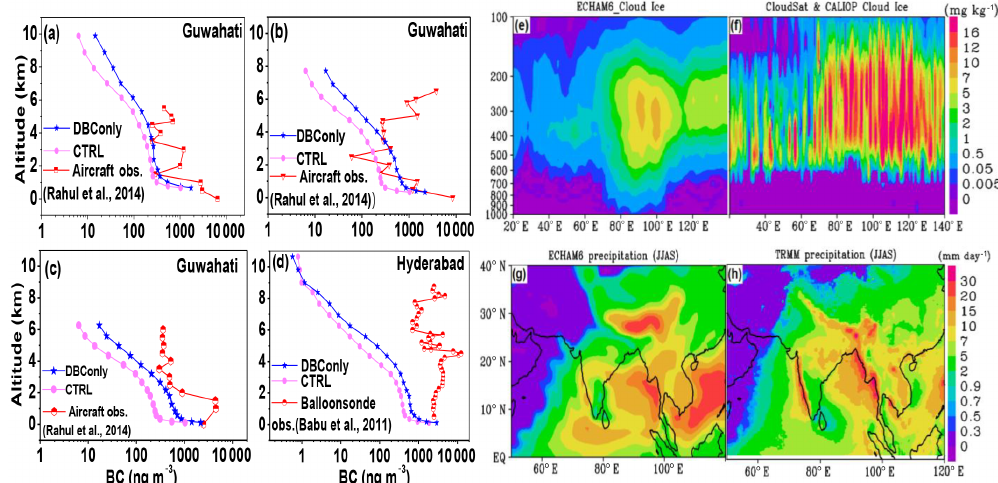
Figure 2. Vertical distribution of BC aerosols (ngm − 3 ). (a) Aircraft measurements on 30 August 2009 at Guwahati (26 ◦ 11 (cid:48) N, 91 ◦ 44 (cid:48) E) (Rahul et al., 2014), CTRL and DBConly simulations for that month extracted at a grid centered at Guwahati. (b) Same as (a) but observations for 4 September 2009 and simulations for the month of September. (c) Same as (a) but for observations on 6 September 2009 and simulations for the month of September. (d) Balloon-borne measurement on 17 March 2010 at Hyderabad (17 ◦ 48 (cid:48) N, 78 ◦ 40 (cid:48) E) (Babu et al., 2011) and CTRL and DBConly simulations for the month of March at a grid centered at Hyderabad. (e) Seasonal mean distribution of cloud ice mass mixing ratio (mgkg − 1 ) averaged for 20–40 ◦ N from CTRL simulations. (f) CloudSat and CALIPSO combined 2C-ICE L3 for the years 2007–2010. (g) Seasonal mean precipitation (mmday − 1 ) obtained from CTRL simulations. (h) TRMM averaged for period